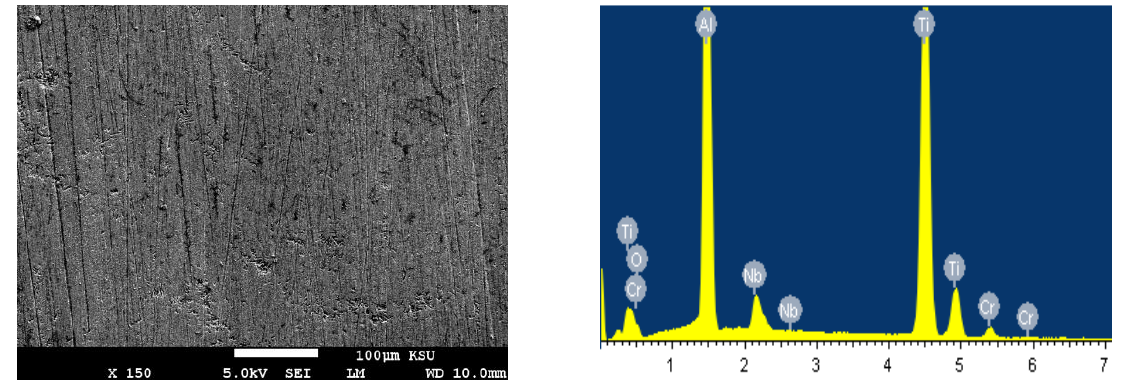
Figure 11. SEM micrograph and EDX profile analysis for the γ-TiAl alloy after its immersion 1 h in 3.5% NaCl solution followed by sweeping the potential from −0.8 V to 0.0 V vs.